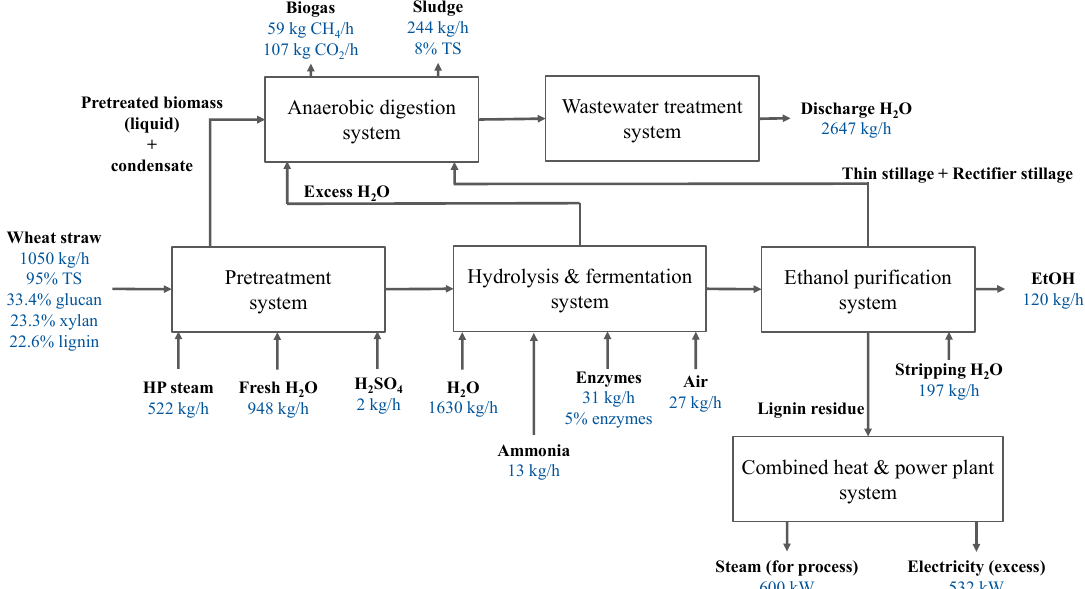
Figure 1. Mass and energy flows in the wheat straw biorefinery, assuming a plant capacity of 1000 kg / h of dry feedstock.